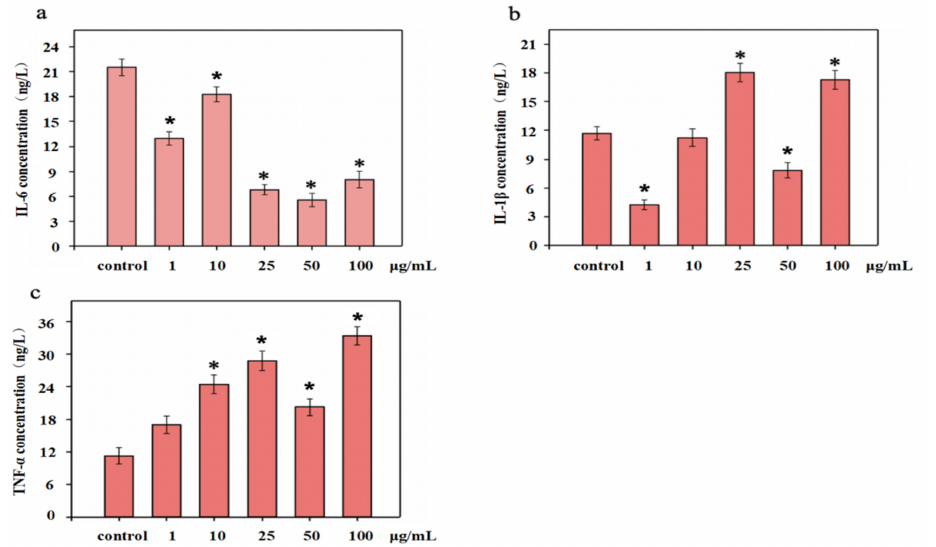
Figure 6. Levels of cytokines in CD8 + T cells treated with varying concentrations of NTCII before LPS stimulation (( a ) IL-6, ( b ) IL-1 β , ( c ) TNF- α ). (Shapiro-Wilk value > 0.05, using one-way ANOVA and Dunnette for post hoc tests.) An asterisk indicates that there is a significant difference compared with the control group (* p < 0.05).